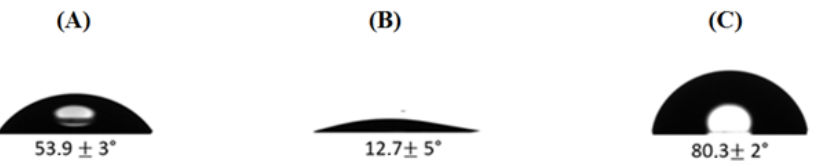
Figure 6. Contact angle on (A) bare HfO 2 before surface activation; (B) bare HfO2 after surface acti- vation by UV/ozone; (C) following TESUD formation.